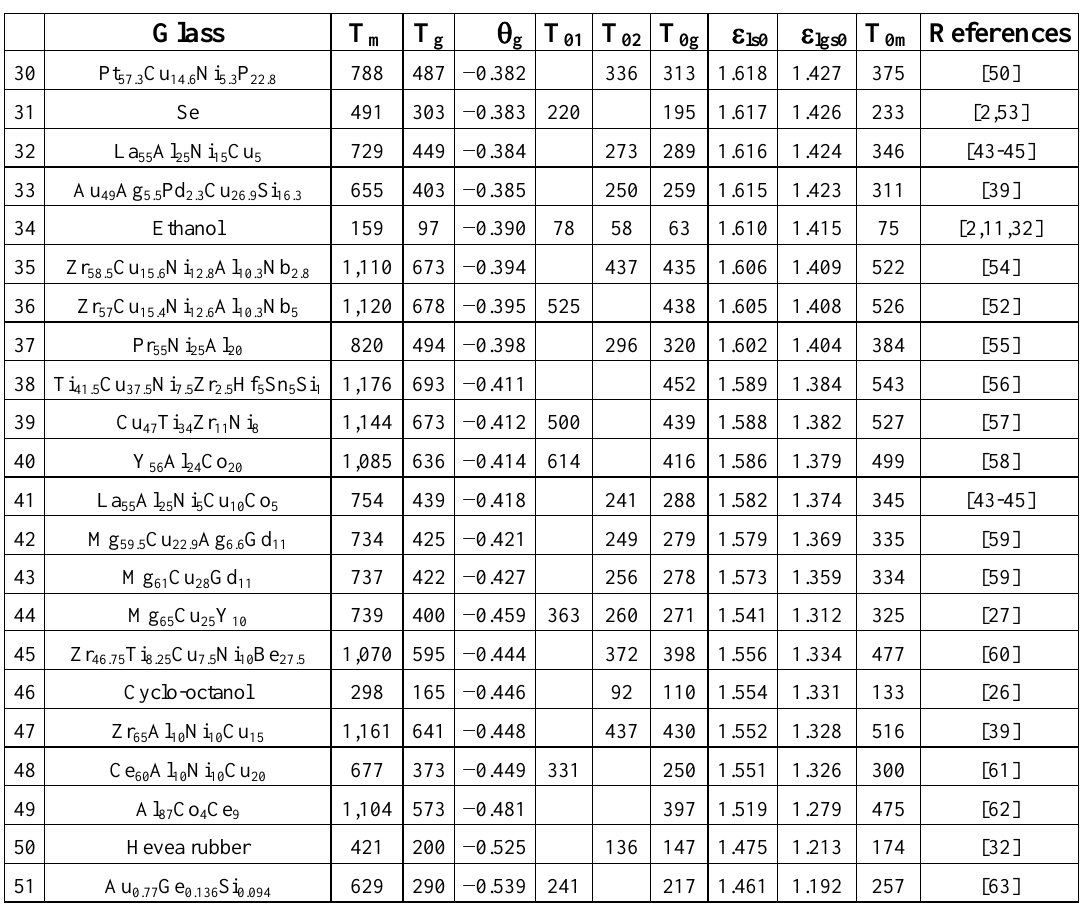
Figure 1. The VFT temperatures T corresponds to measurements in the vicinity of T at higher temperatures. T